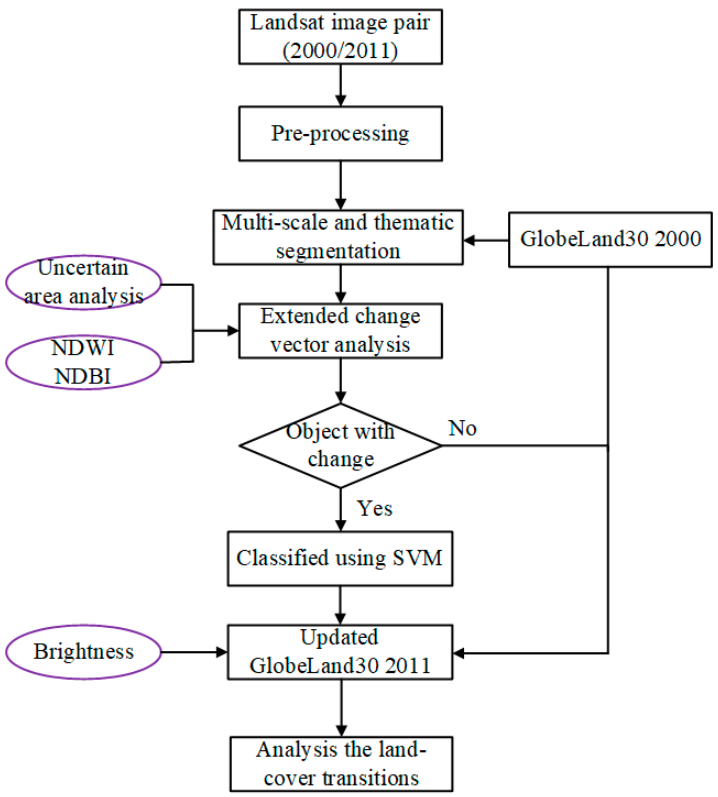
Figure 2. Framework of the proposed method.